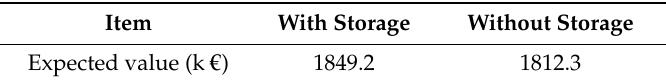
Table 15. Expected